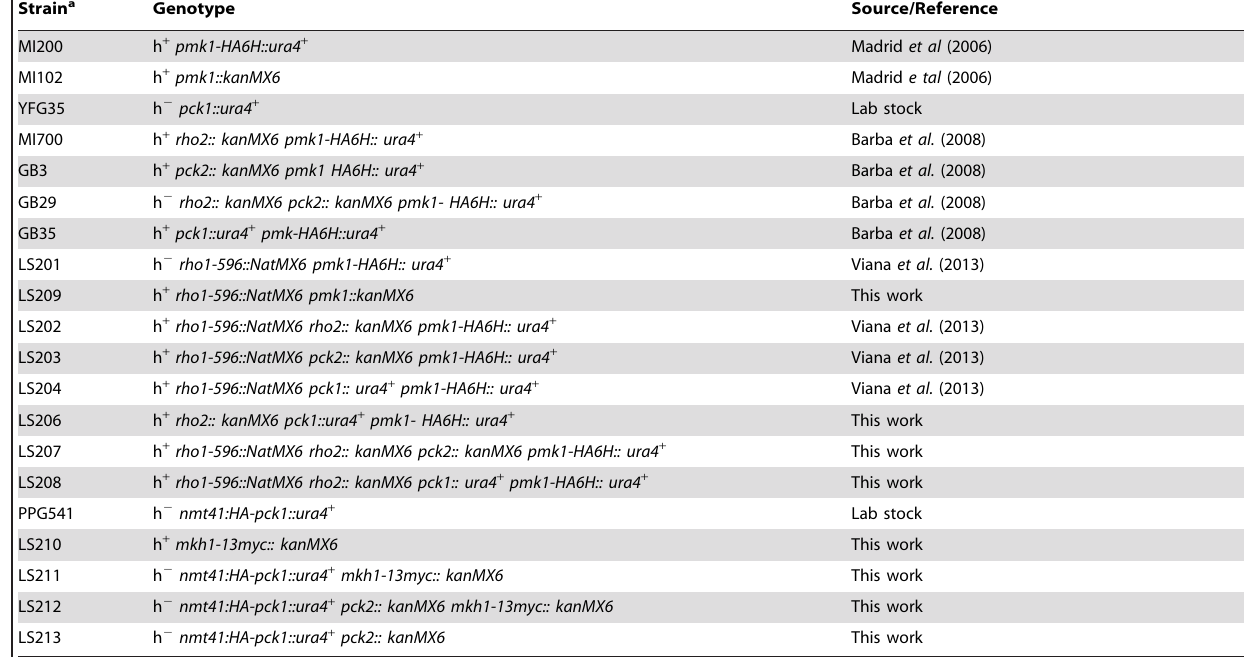
Strain a Genotype